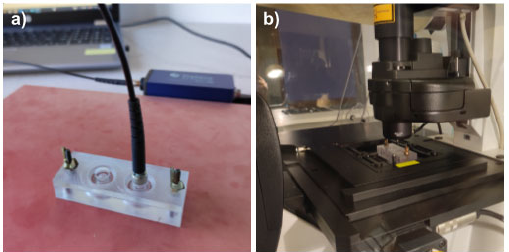
Figure 4. Oxygen measurements and confocal microscopy. ( a ) Demonstration of a cell culture de ‐ vice placed on the hot plate set to 37 °C while measuring the oxygen concentration by insertion of the optical fibre into the top cavity for readout of the signal from the fluorescent oxygen ‐ sensitive spots integrated into the lid. ( b ) Demonstration of the cell culture device standing on the Leica SP5 confocal microscope equipped with environmental chamber set to 37 °C and 5% CO 2 .